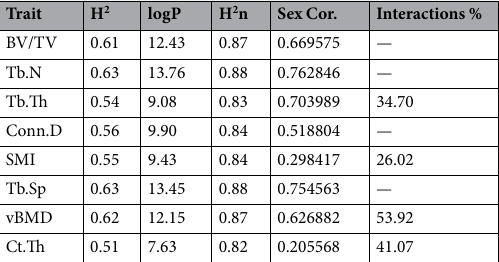
Table 1. Heritability, sex correlations, and covariate interactions for trabecular and cortical traits. H 2 is the broad-sense heritability (which includes epistatic and environmental influences); logP is the negative 10-base logarithm of the P-value; H 2 n is the line-mean heritability; Sex Cor. is the sex correlation of each trait; and interactions % refers to the relative contribution of the cumulative covariate-interactions, which include sex, age, batch, month, season, year, and experimenter (see Table